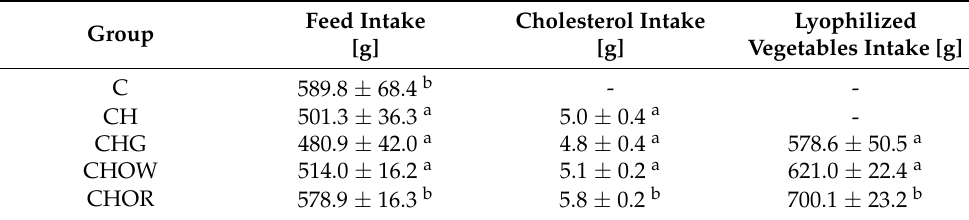
Table 2. Comparison of feed intake, cholesterol, and lyophilized vegetables (garlic, white onion, and red onion) intake in rats fed the control and the cholesterol-containing (1% of cholesterol) diet during the 28 day experiment.